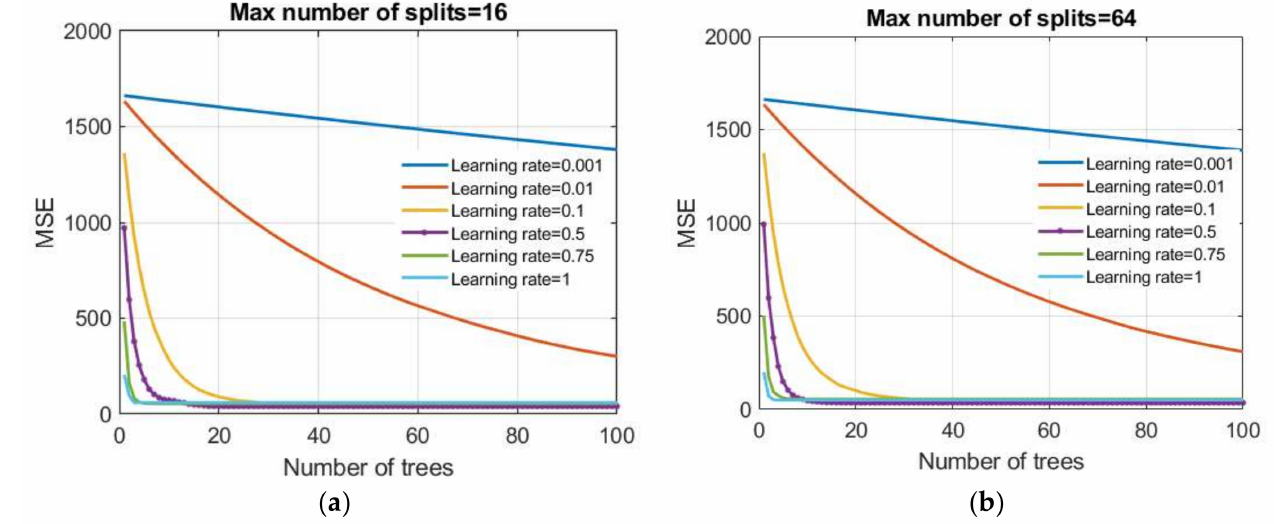
Figure 15. Dependence of the MSE value on the reduction parameter λ and the number of trees (base models) in the boosted trees model: ( a ) the maximum number of splits is limited to 16 and ( b ) the maximum number of splits is limited to